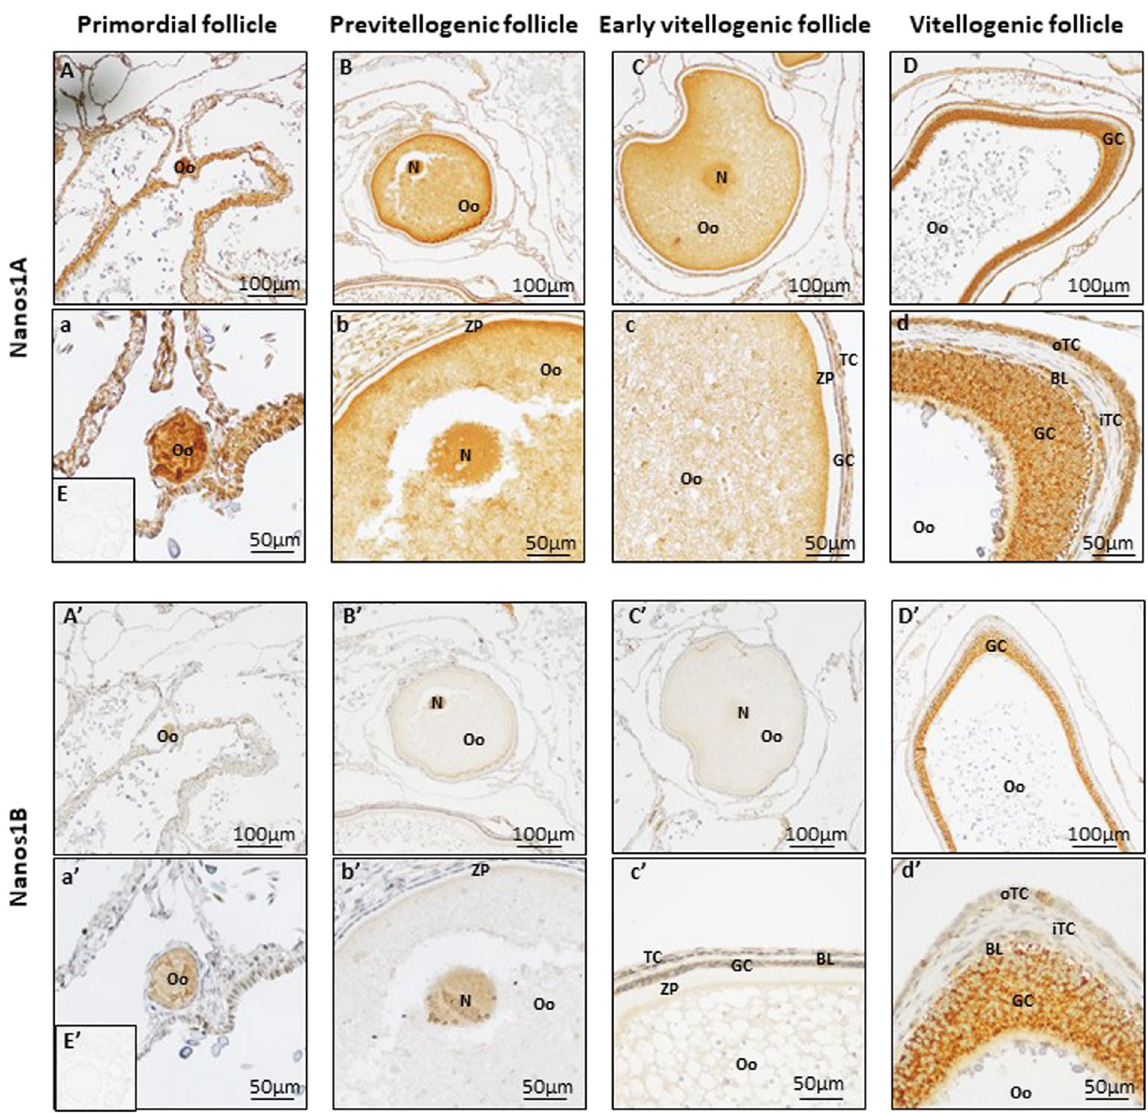
Figure 8. Nanos1A and Nanos1B proteins share a similar expression profile in dogfish ovary. Immunohistochemistry has been performed on dogfish ovaries paraffin sections to detect Nanos1A ( A – D , higher magnification in a–d) and Nanos1B (A’–D’, higher magnification in a’–d’). 3,3 ′ -diaminobenzidine (DAB) was used for the revelation. E and E’ illustrate the negative control. The Nanos1A protein was detected in primary oocytes from primordial follicles (around 100 µ m in diameter, A,a) to early vitellogenic follicles (around 500 µ m in Ø, C ,c) in the cytoplasmic and nuclear (N) compartments. Staining in oocytes became progressively undetectable whereas it appeared in granulosa (GC) and outer theca cells (oTC) of early ( C ,c) and more advanced vitellogenic follicles ( > 2 mm in Ø, D ,d). Similarly, Nanos1B was detected in oocytes of primordial follicles (A’,a’). In previtellogenic follicle (B’b’), Nanos1B presented a major expression in oocyte nucleus (N). Finally, Nanos1B was observed in granulosa cells (GC) and outer theca cells (oTC) in vitellogenic follicles (C’,c’ and D’,d’). BL: basal lamina, GC: granulosa cells, iTC: inner theca cells, N: nucleus, Oo: primary oocyte, oTC: outer theca cells, ZP: zona